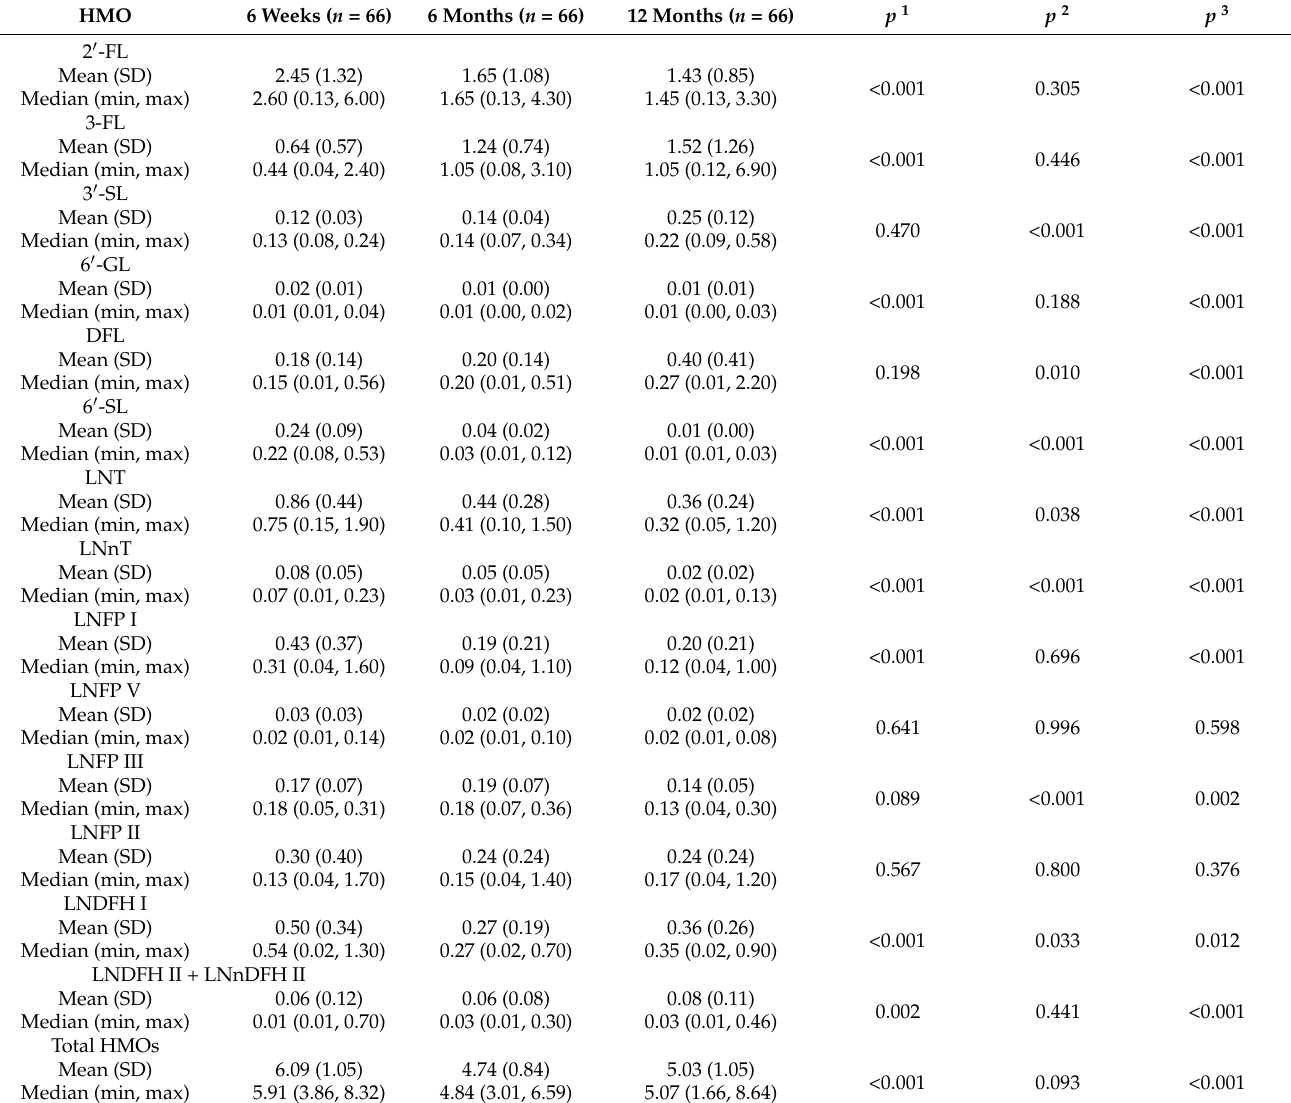
Table 2. Absolute concentrations of human milk oligosaccharides (HMOs) measured in g/L at 6 weeks, 6 months, and 12 months of lactation in the Ulm SPATZ Health